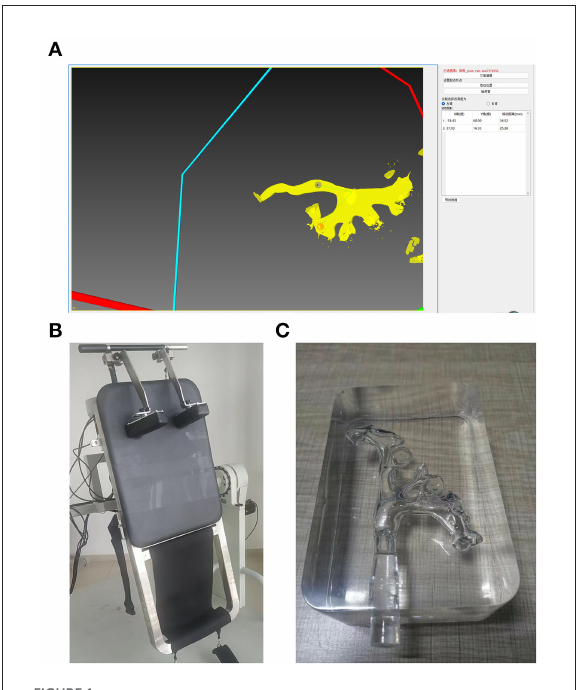
FIGURE1 Postural drainage lithotripsy system. (A) Stone clearance path planning software, the red point is the targeted calyx, and the blue point is in the UPJ. ( − 74, 60) and (37, 16) are the ( X , Y )-axis parameters of the space rotating bed. (B) The space rotating bed. (C) 3D printed kidney